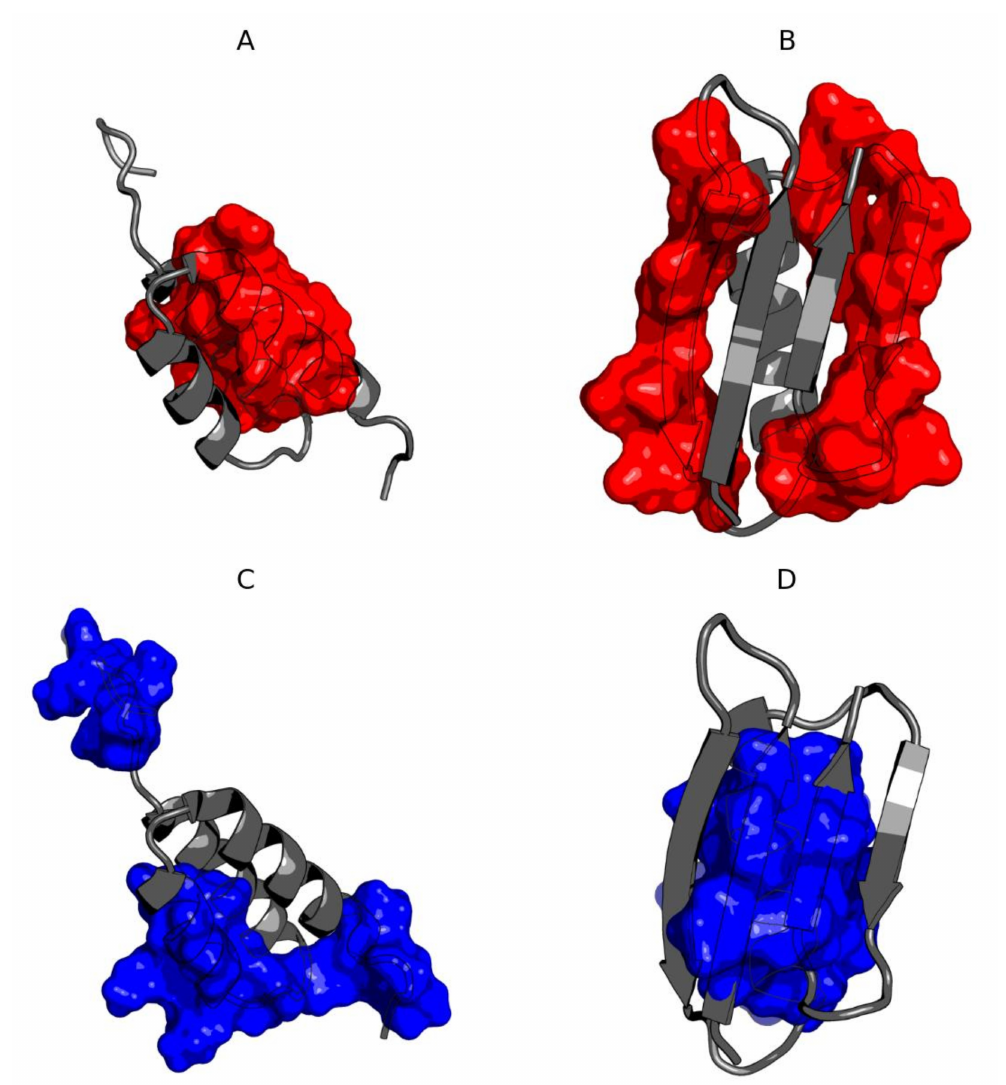
Figure 7. 3D presentation of Ga98 ( A , C ) and Gb98 ( B , D ) showing significant di ff erences in the location of hydrophobic core. ( A ) Members of hydrophobic core of Gb98 (12–20, 39–49) in Ga98; ( B ) Members of hydrophobic core of Ga98 (12–20, 39–49) in Gb98; ( C ) Members of hydrophobic core of Ga98